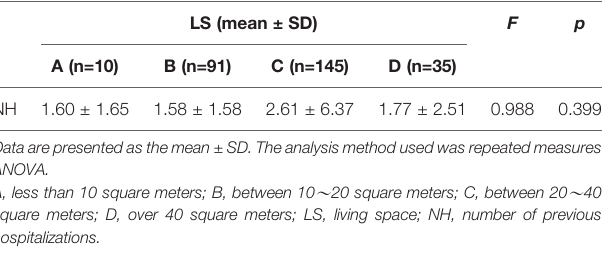
TABLE 3 | Comparative analysis of the number of hospitalizations in different living